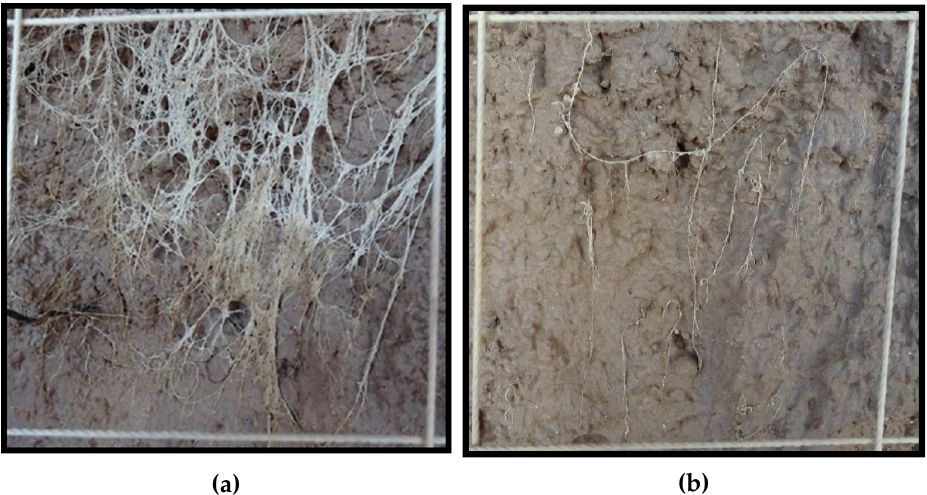
Figure 4. Roots of physiologically mature barley varieties at 90–100 cm depth when grown under low irrigation in 2018: ( a ) “Solar” roots; ( b ) “Kopious”